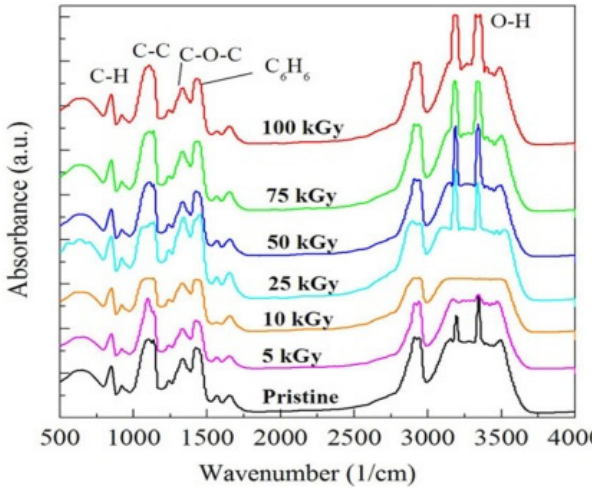
Figure 3. FTIR spectra of the irradiated and pristine NC films.